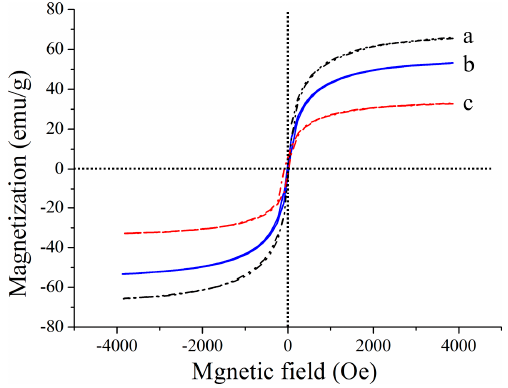
Figure 3. Magnetization hysteresis of Fe3O4 (black), AMNPs (blue) and MMs (red).